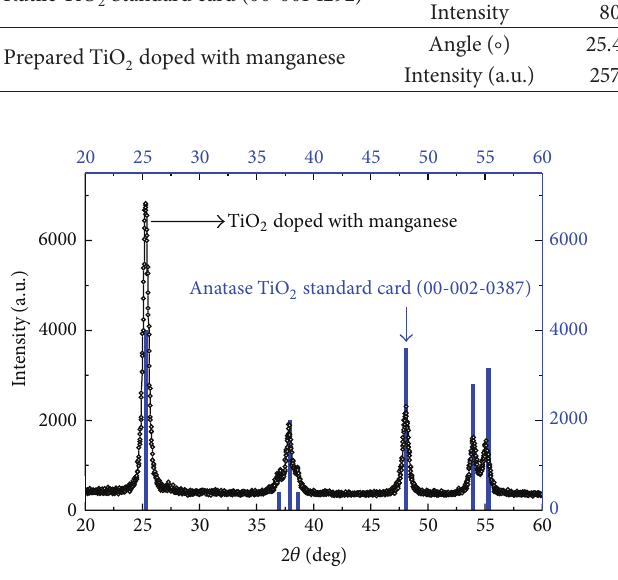
Table 2: Comparing diffraction angles and intensity of rutile TiO Rutile TiO Standard card (00-001-1292) 2